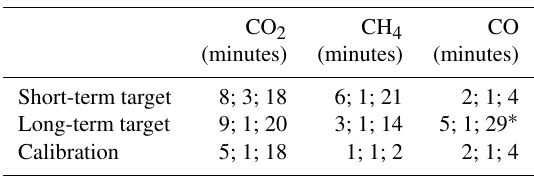
Table 6. Cylinder sample stabilization time estimated during the initial test period. The mean, minimum and maximum (mean; min; max) for the 23 stations are